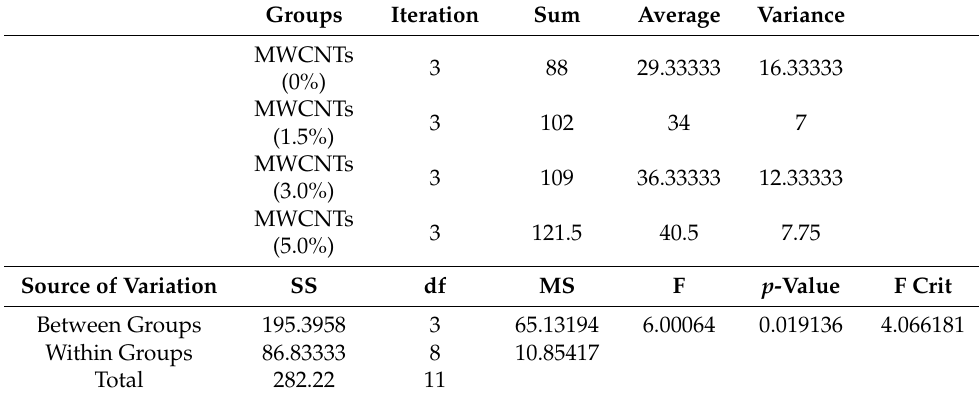
Table 11. MOR values of MWCNTs-UF MDF for various